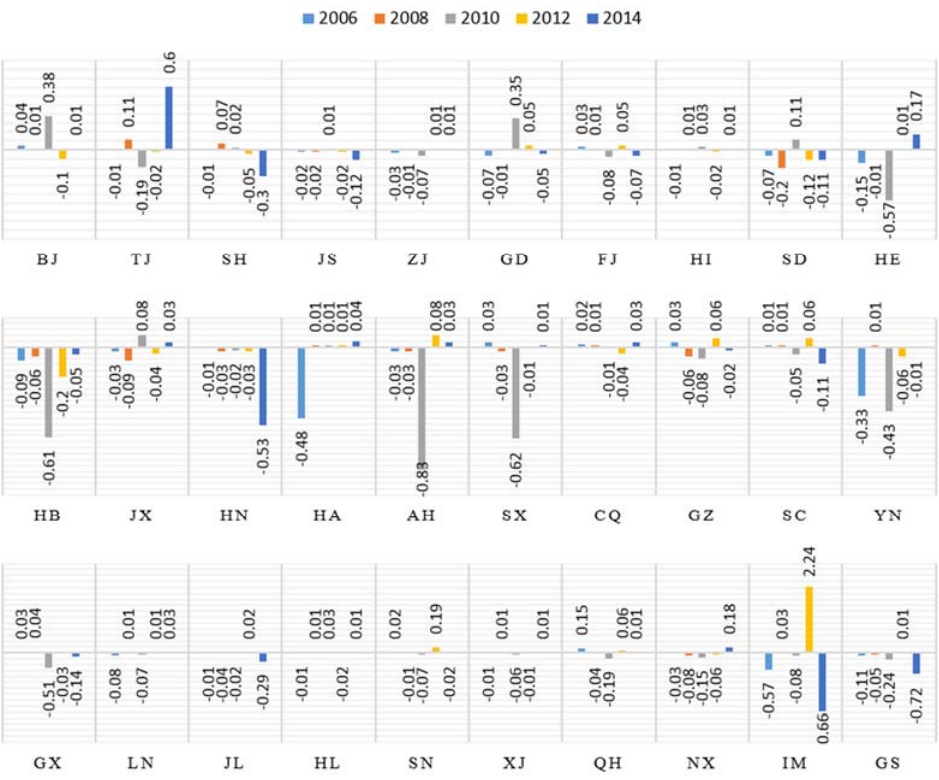
Figure 7. Contributions of unit value energy consumption of 30 provinces in 2006, 2008, 2010, 2012 and 2014.